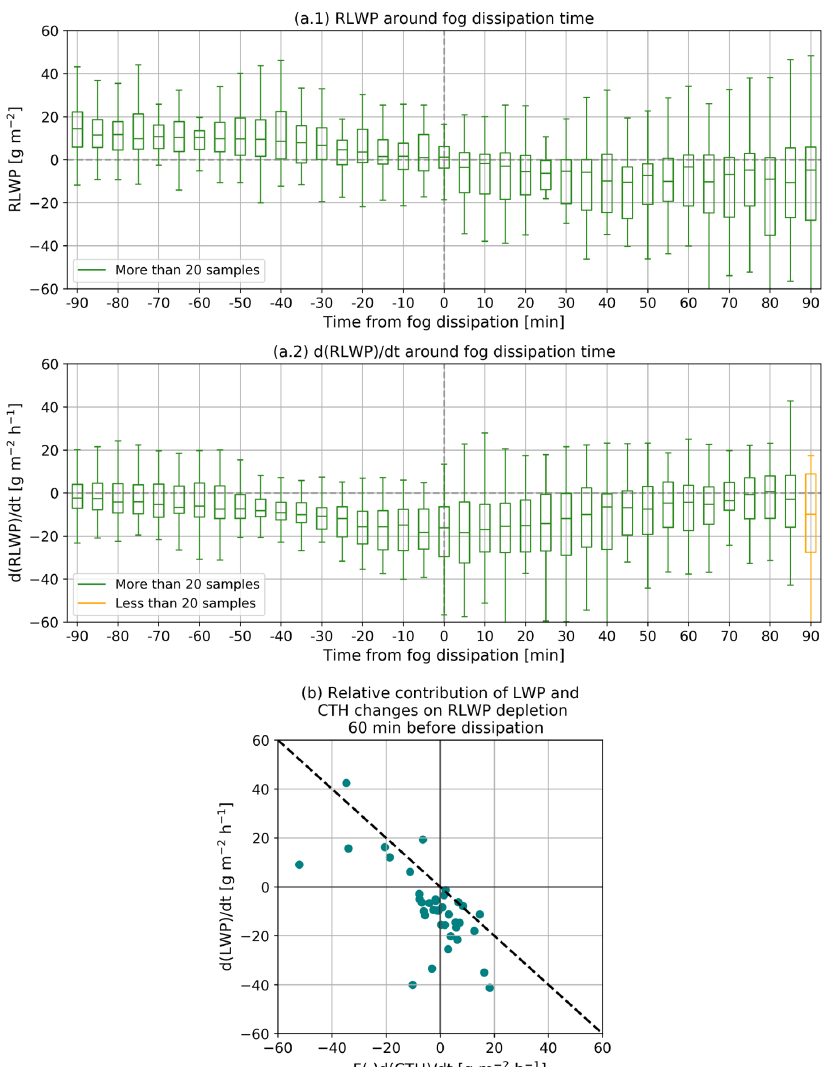
Figure 11. The boxplots of (a.1) and (a.2) show RLWP and dRLWP / d t statistics for each time block, 90min before and after fog dissipation. These statistics are derived using 56 fog events; however, there may be less than this amount of valid samples for each bin. The number of valid samples per bin is shown in Fig. S3 of the Supplement. Panel (b) shows the impact of LWP and CTH variations in RLWP depletion, using data from the last 60min before dissipation. The dashed line indicates the theoretical limit where fog dissipation is possible (only to the left of this line). In quadrants II and III cloud base lifting contributes to RLWP decrease, while in quadrants III and IV the LWP decrease contributes to RLWP depletion. This panel contains 40 valid samples from 56 fog cases, calculated using the method explained at the beginning of Sect.